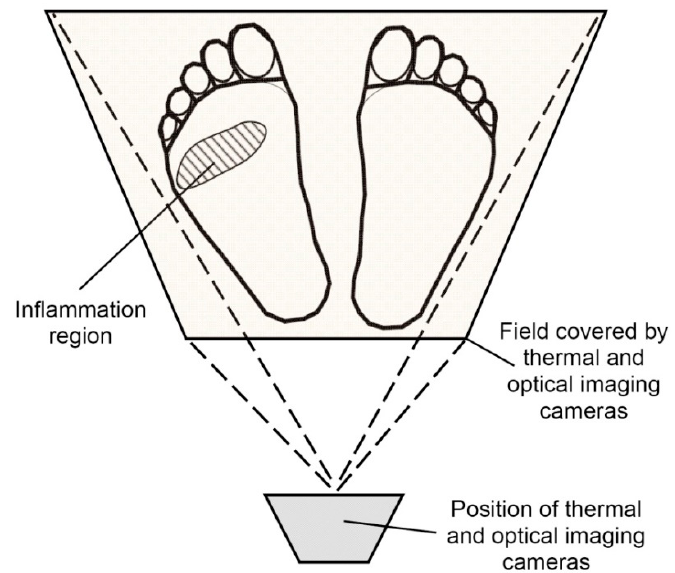
Figure 3. The experimental set-up.